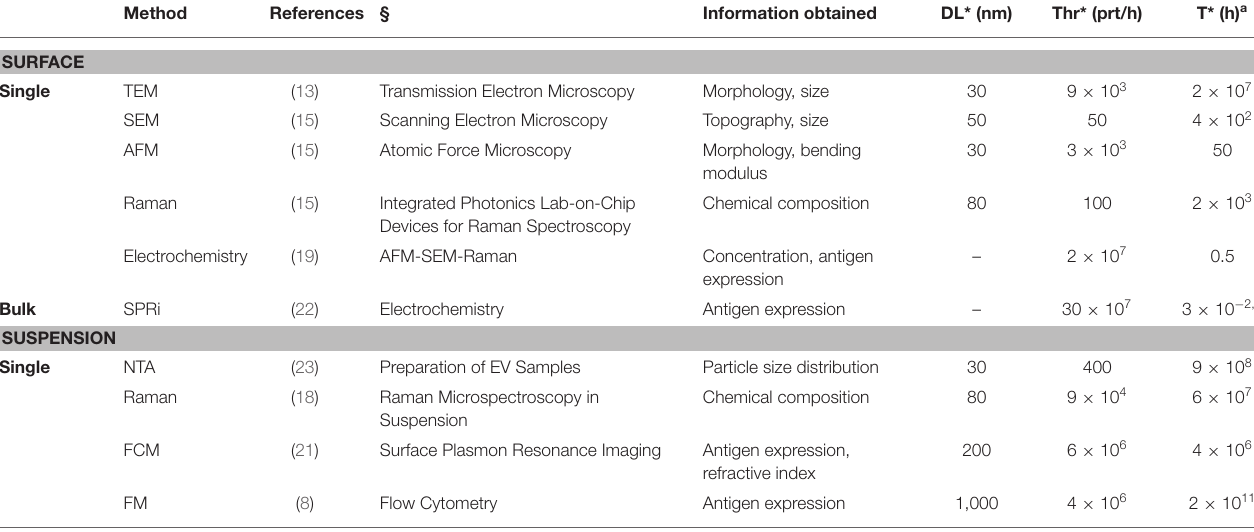
TABLE 1 | Overview of the techniques used in